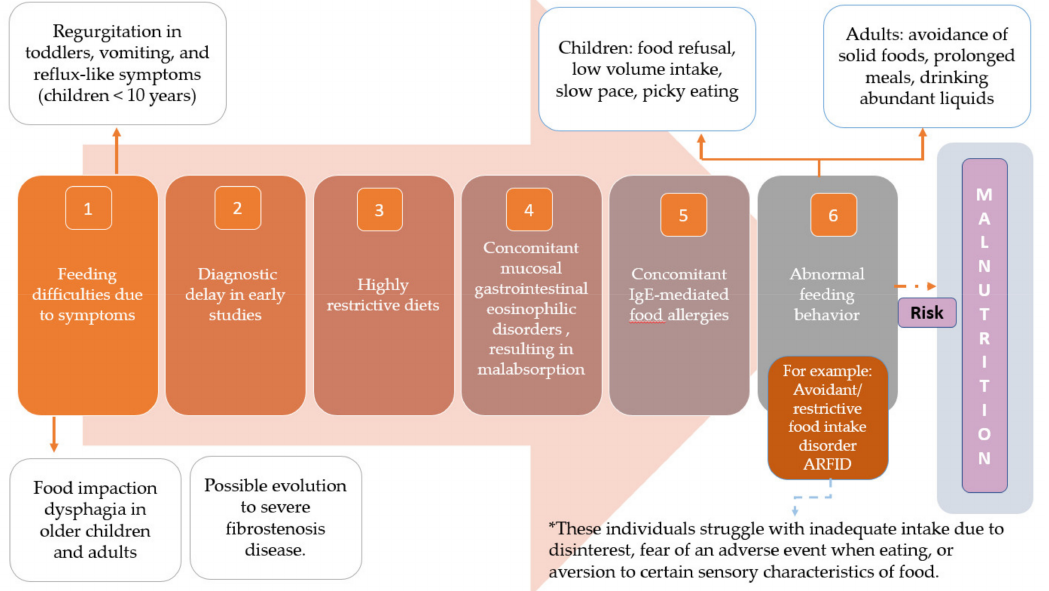
Figure 3. Six potential reasons contributing to the development of malnutrition in children or adults with EoE. Adapted from Molina Infante J with permission (Ref.